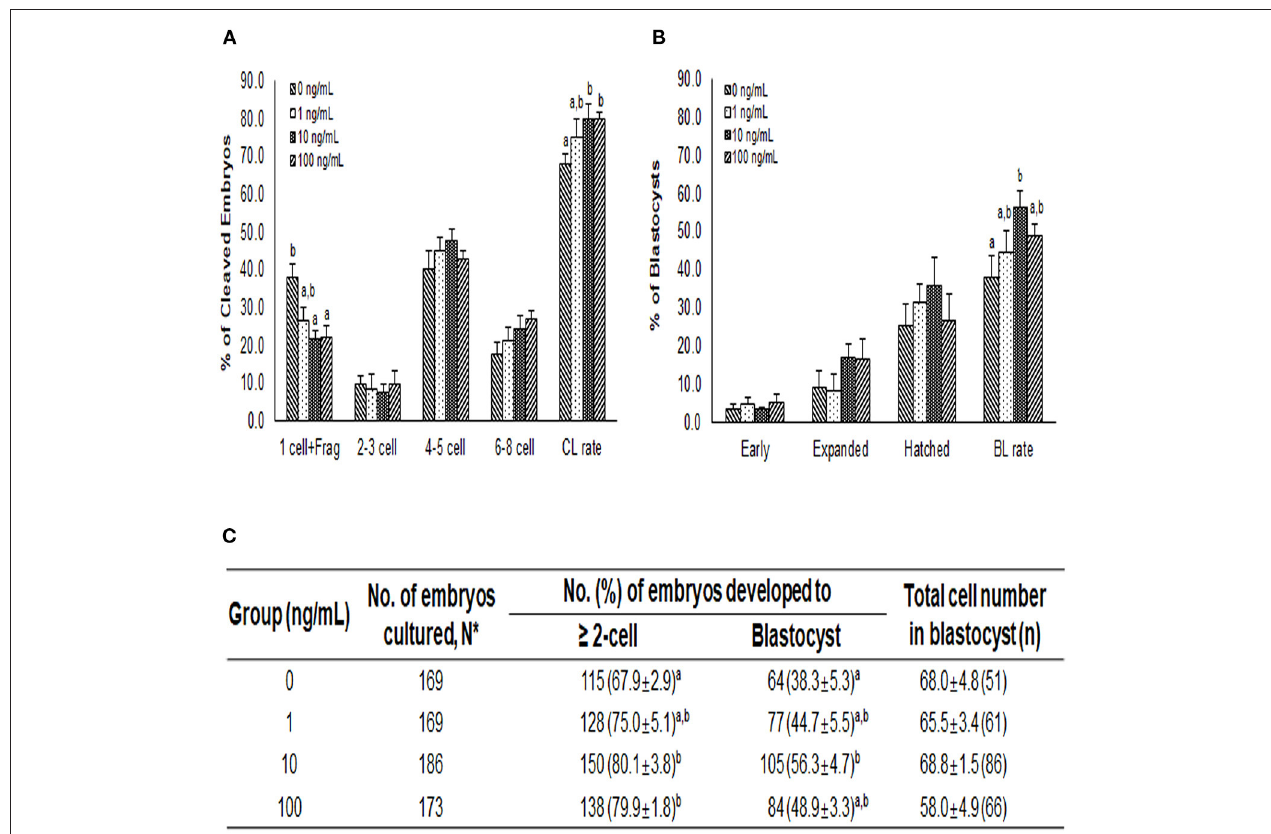
FIGURE 6 | Effect of NT-4 treatment during in vitro maturation (IVM) on embryonic development after parthenogenetic activation (PA) in terms of (A) the cleavage pattern and (B) the blastocyst formation pattern of the PA embryos. Within each end point, bars with different letters (a, b) are significantly ( p < 0.05) different for different concentrations of NT-4 treatment. CL, cleavage; BL, blastocyst. (C) Summary of embryonic development after PA. The cleavage rate was measured on day 2, and the blastocyst formation rate was evaluated on day 7 of culture. *N: Four times